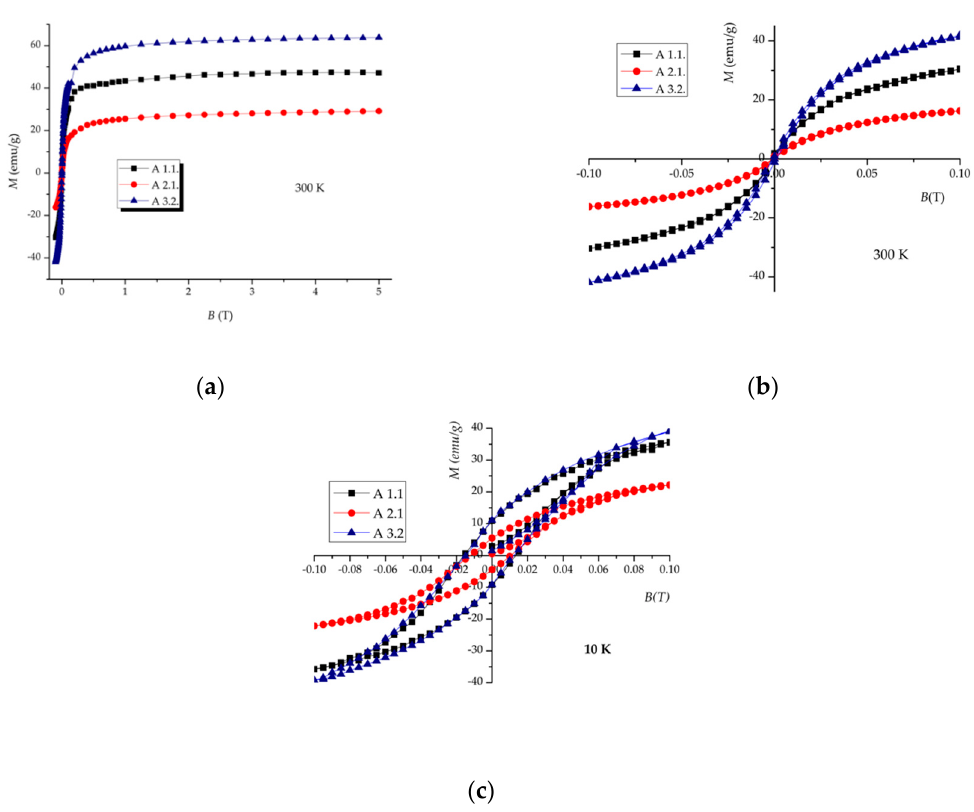
Figure 6. Temperature dependence of magnetization (ZFC/FC curves at 25 G) and AC susceptibility (out-of-phase component χ ’’ at 995 Hz) of naked SPIONs: ( a ) A 1.1, ( b ) A 2.1, ( c ) A 3.2.